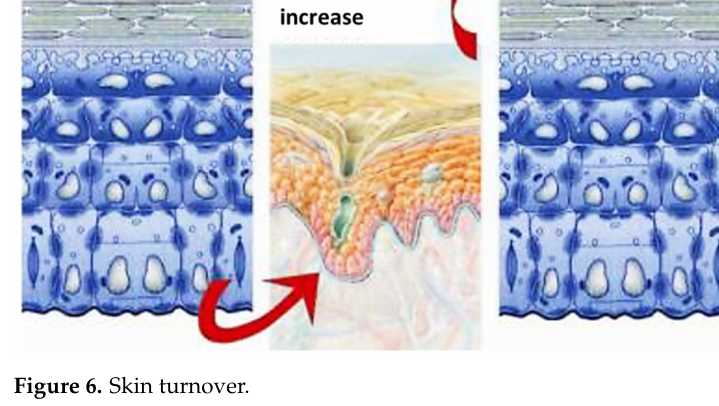
Figure 6. Skin turnover.